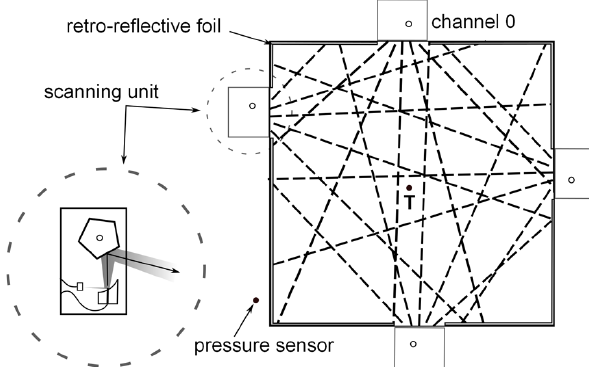
Figure 1. Schematic drawing of the tomographic setup (top view). Four scanning units are placed on the edges of a 0.8m × 0.8m mea- surement field. The circumference of the remaining area is covered with low-cost retro-reflecting tape. Some exemplary laser beams are depicted as dashed lines. A schematic illustration of the scanning unit contents is shown in the detail circle. The components are de- scribed in Sect. 3. Temperature sensor (T) was placed in the middle of the area while the pressure sensor measures the room pressure in a distance of about